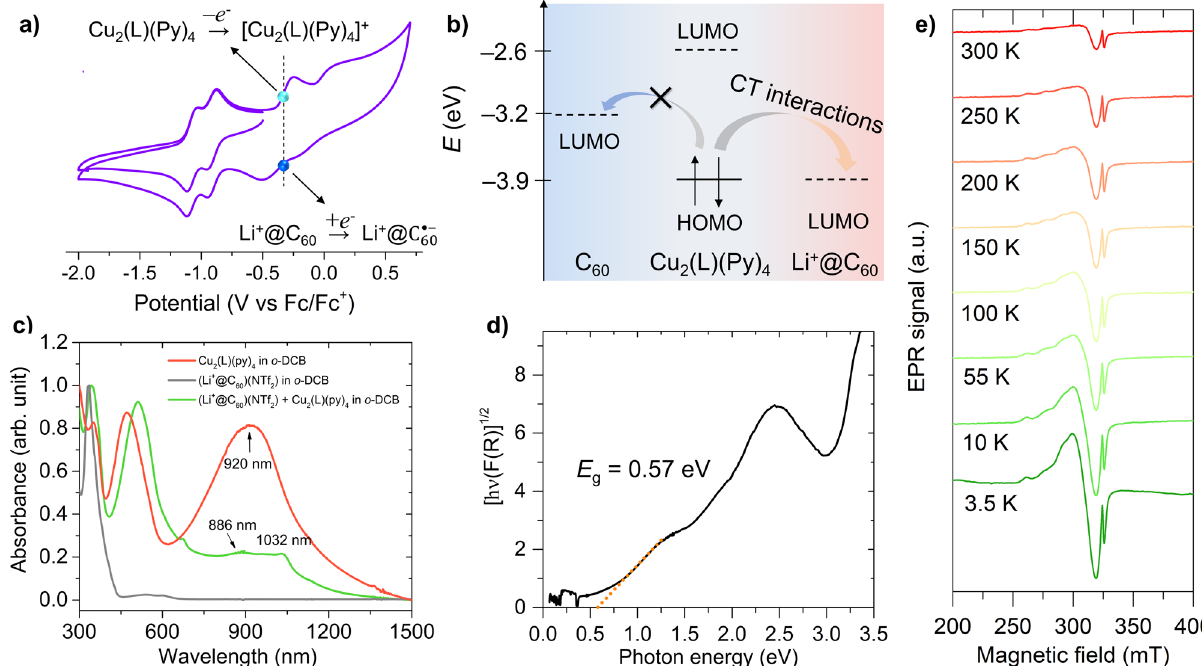
Fig. 3 Spectroscopic characterization. a Cyclic voltammogram ( − 2.0 to 0.8 V versus Fc/Fc + ) of Cu 2 (L)(py) 4 in o -DCB with 0.1 M TBAPF 6 as the supporting electrolyte. The pale blue dot at E = − 0.39 eV represents the fi rst reduction potential from Li + @C 60 to Li + @C 60 (cid:129) − . b Schematic of charge- transfer interactions of HOMO and LUMO orbital energies between Cu 2 (L)(py) 4 and Li + @C 60 calculated from the cyclic voltammogram. The HOMO energy level of Cu 2 (L)(py) 4 is identical to the LUMO energy level of Li + @C 60 , indicating strong CT interactions. c In situ solution-state UV – Vis-NIR absorption spectra at room temperature. d Tauc plot of room-temperature diffuse re fl ectance UV − vis − NIR spectra of 1 from 0.05 to 3.3 eV, obtained via Kubelka – Munk transforms (F(R)) for indirect allowed transition. The optical bandgap is determined as 0.57 eV by the linear fi t (orange dots) of absorption onset in the NIR energy region. e First-derivative solid-state X-band absorption EPR spectra of 1 for 3.5 ‒ 300